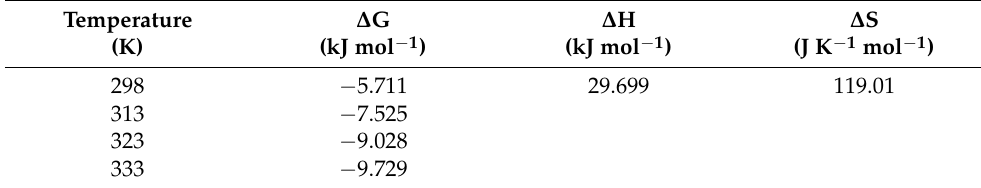
Table 2. Thermodynamic